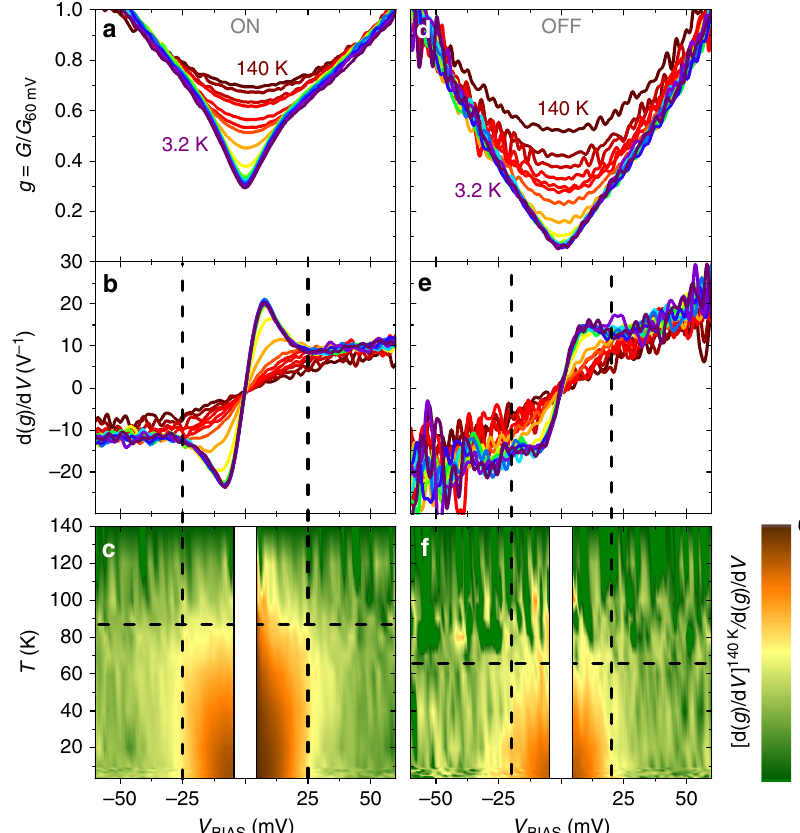
Fig. 4 Temperature dependence of the spectral features. For a 3 nm BFO junction, in the ON state ( a ) and OFF state ( d ): differential conductance normalised to the conductance at 60 mV, G ( V BIAS )/ G 60mV , for different temperatures in the series 3.2, 4, 5, 6, 7, 8, 9, 10, 20, 40, 60, 80, 90, 100, 120, 140 K, which correspond to the different curve colours. The series extrema are indicated by the labels. b , e respectively, show the fi rst derivative dG / dV BIAS of those curves. c , f shows the ratio between the dg / dV BIAS at T = 140 K and dg / dV BIAS at any other temperature as a function of the bias voltage and temperature. The range V BIAS < 5 mV is masked because the ratio between two values close to zero yields a large data scattering. The vertical dashed lines show the bias span of the gap feature, the horizontal dashed lines point the critical temperature at which the gap starts